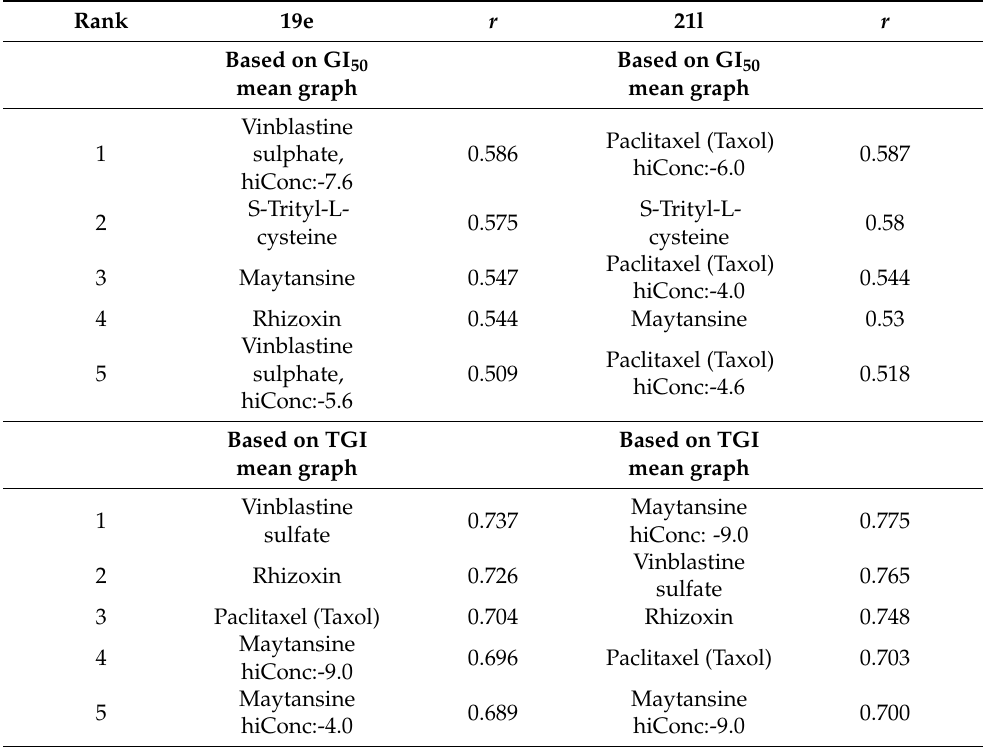
Table 4. Standard COMPARE analysis of compounds 19e and 21l a